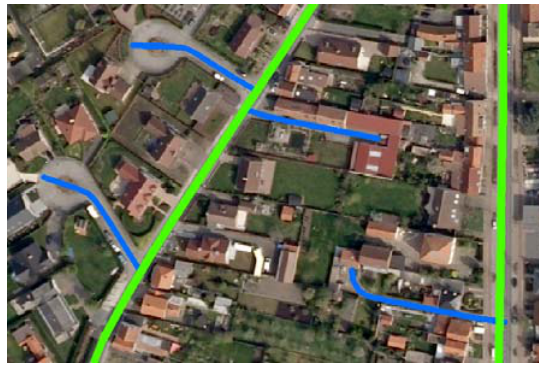
Figure 11: Undetected road objects